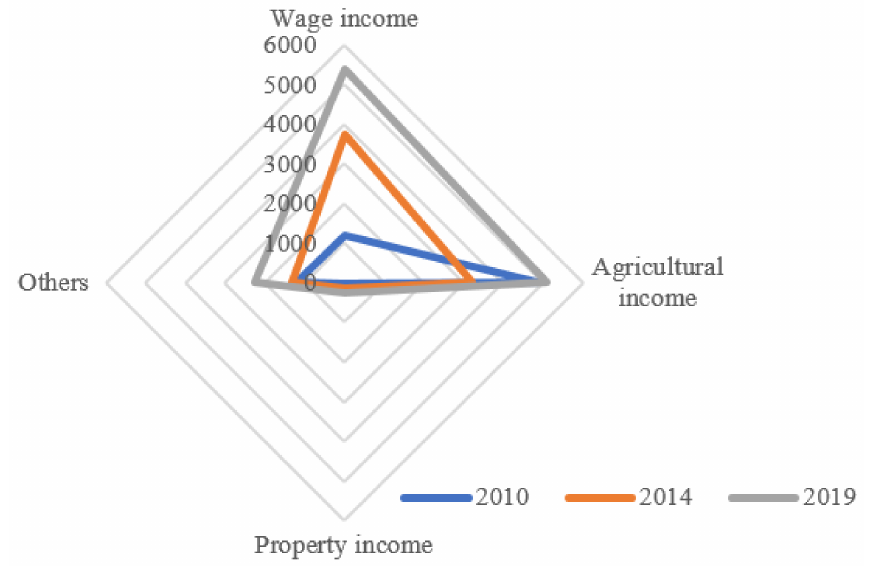
Figure 9. The per capita income structure change of rural household in Taibus from 2010 to